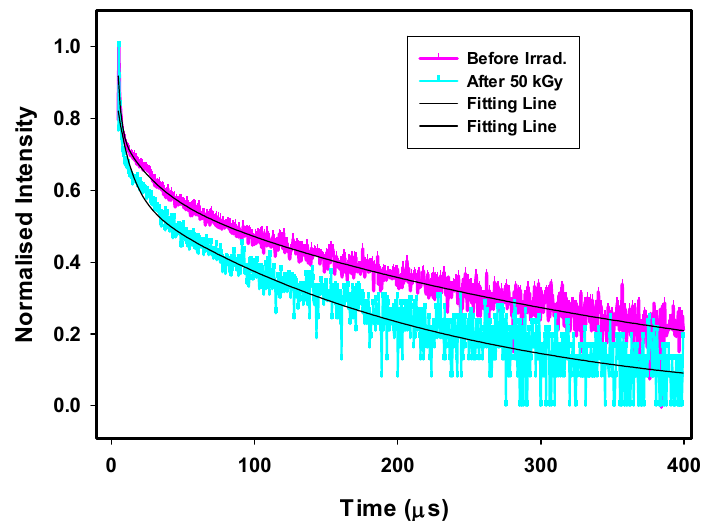
Figure 10. Luminescence decay profiles of the 4F9/2 level of GRD glasses before and after gamma irradiation.